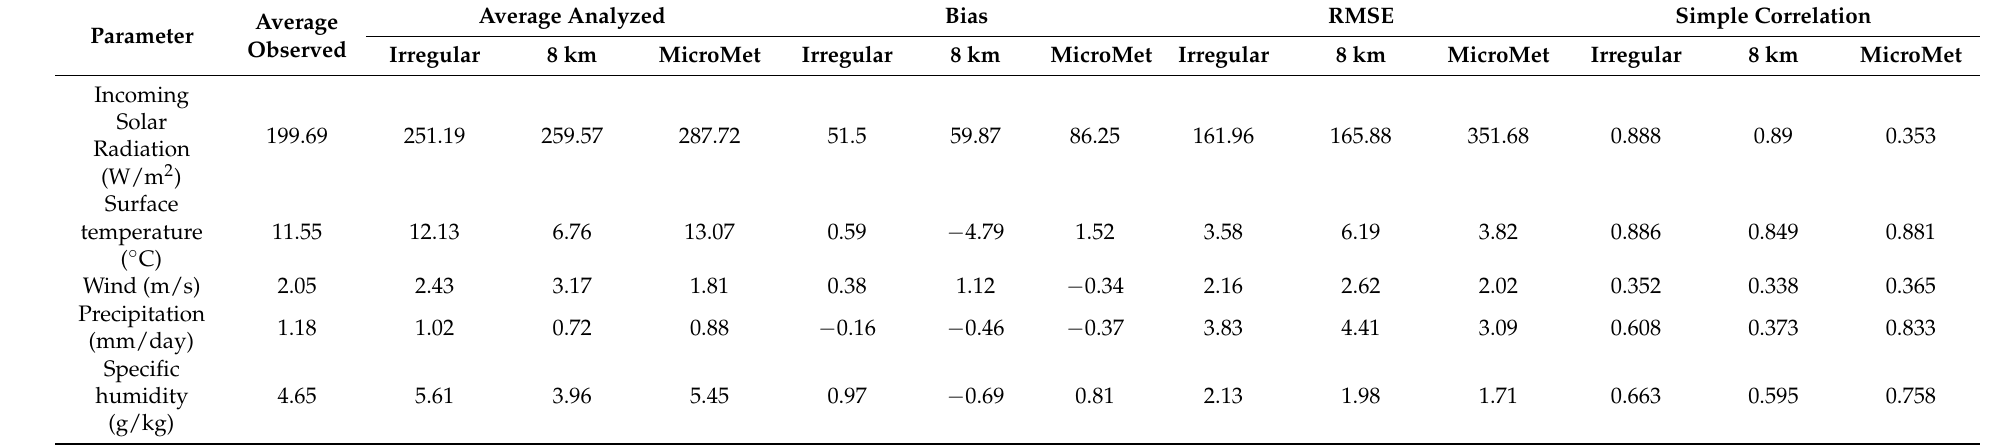
Table 2. Evaluation of SAFRAN (8 km and Irregular) and MicroMet model at the Aremd station 2004–2014. (The evaluation of MicroMet was carried out between 2004–2012). Average Analyzed Bias RMSE Simple Correlation Average Parameter Observed Irregular 8 km MicroMet Irregular 8 km MicroMet Irregular 8 km MicroMet Irregular 8 km